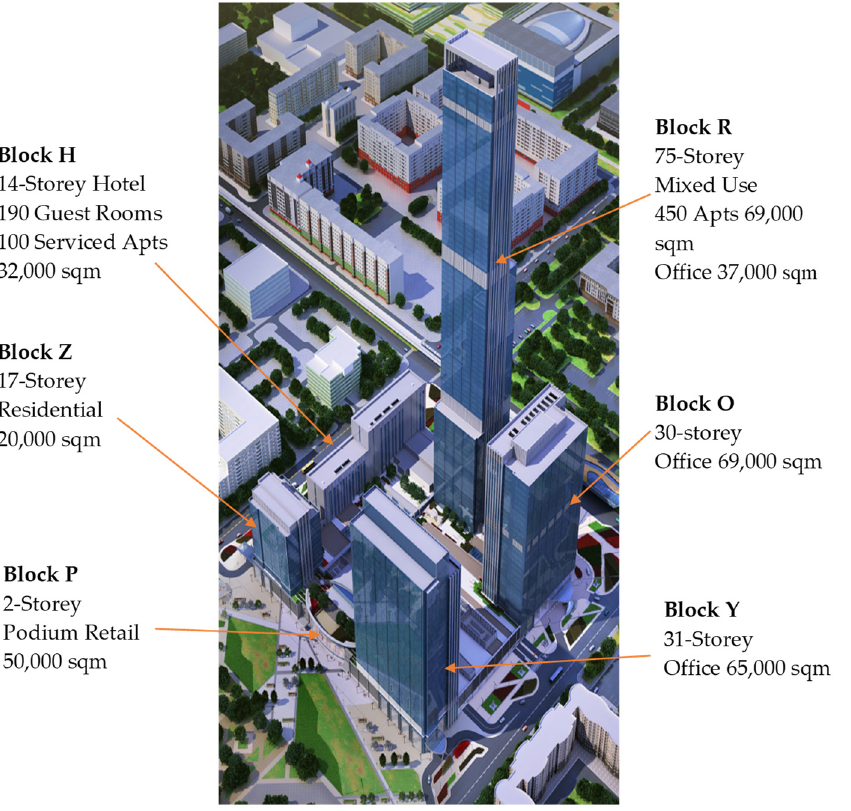
Figure 3. Abu Dhabi Plaza Building Complex.